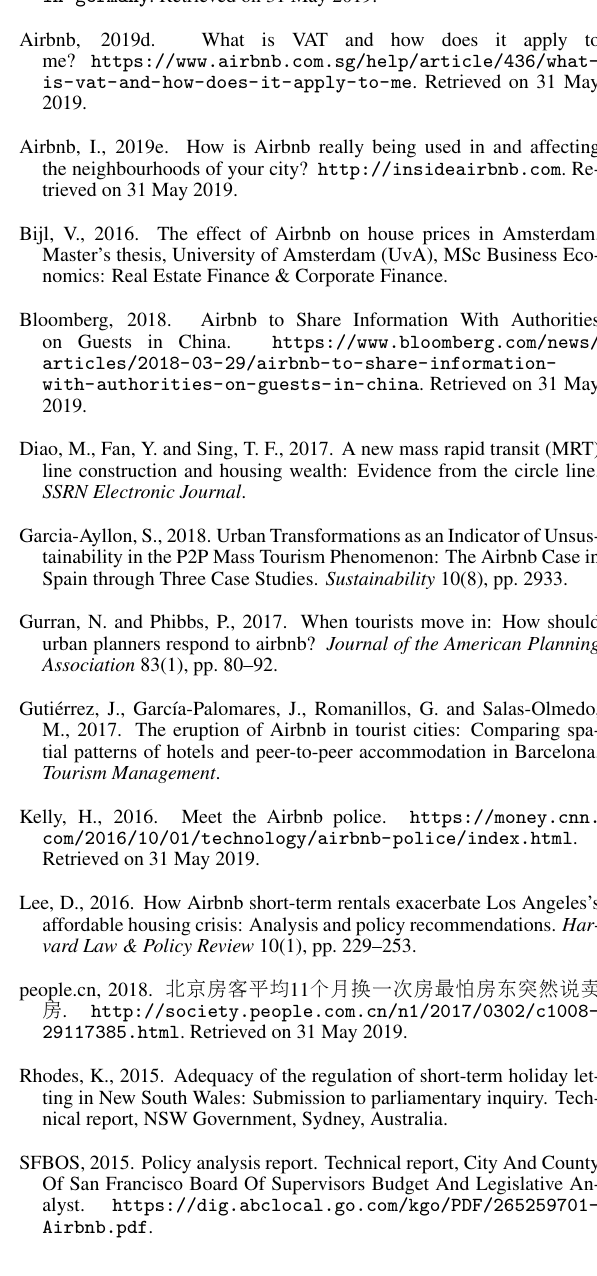
Figure 12. Sensitivity score of neighbourhoods in Men Tou